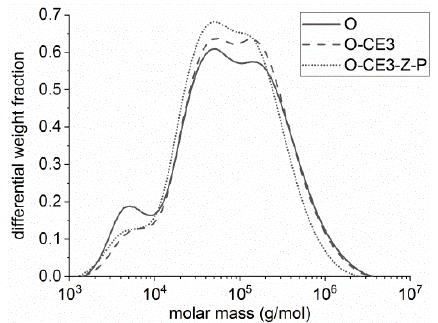
Figure 5. Distribution of pulp molecular weight.